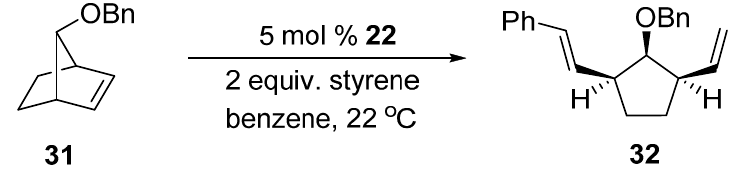
Figure 4. Examples of silica-supported olefin metathesis catalysts 18 – 21 .